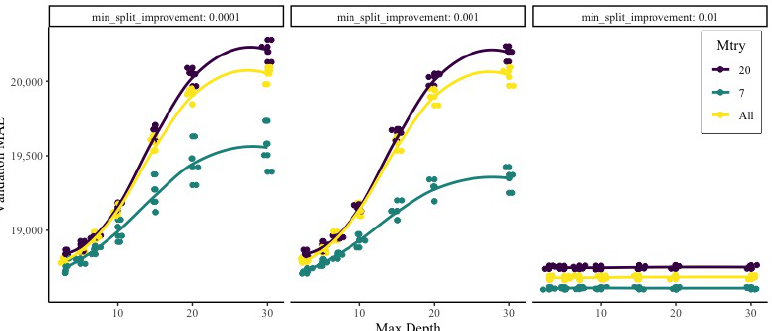
Figure 5. Visualization of the results from tuning random forests to predict severity on the BI data. MAE (as computed on the validation set) is shown on the y -axis as it varies according to the max depth of each tree in the forest. Each pane shows a different minimum split improvement value, with the different colors representing different values of the mtry tuning parameter.